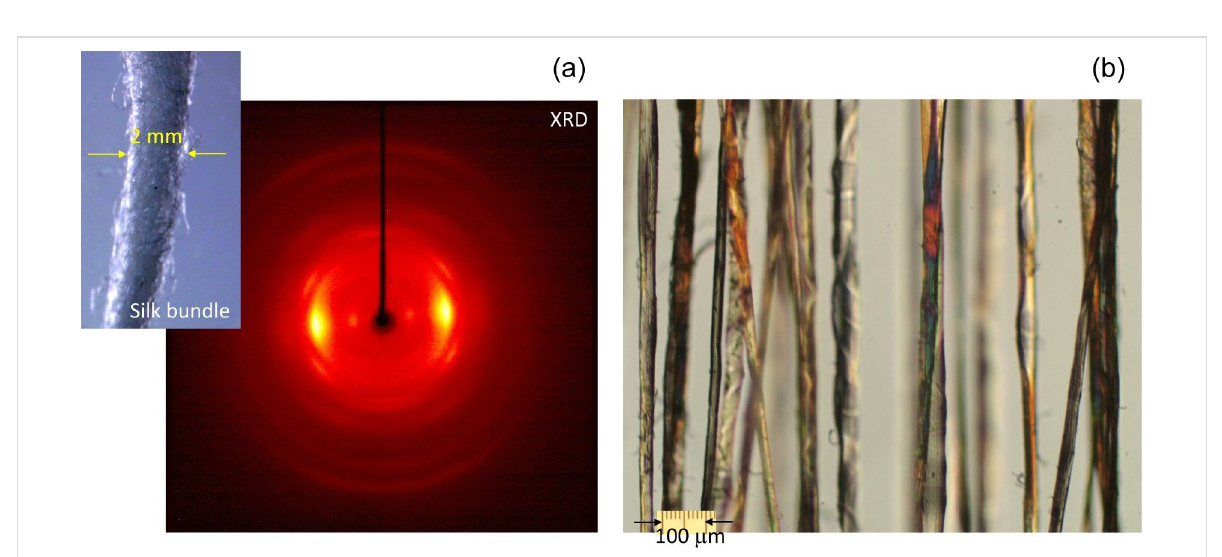
Figure 2: (a) Wide-angle 2D X-ray diffraction of a bundle of white Bombyx mori silk fibers. The inset shows an optical microscopic image of a convolved silk fiber bundle. The silk bundle was composed of degummed single-strand silk fibers. The long axis of the fibers was predominantly vertical. (b) Optical image of white silk fibers through an optically aligned polariser–analyser (high-transmission) setup under white-light illumination using a Nikon MPlan 10× DIC objective lens with numerical aperture NA =